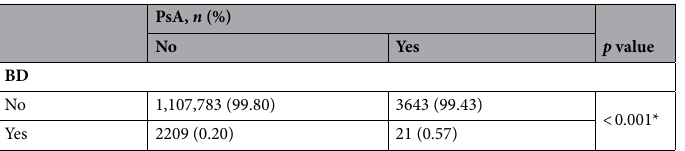
Table 5. Prevalence of psoriasis by Behçet disease status. BD, Behçet disease; PsA, psoriatic arthritis. *Statistically significant for p <